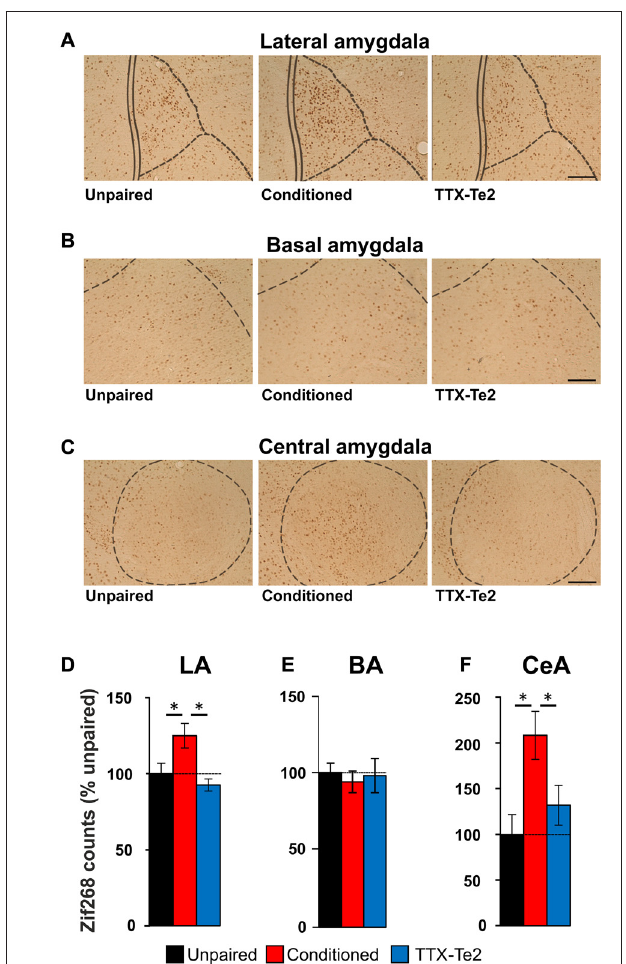
FIGURE 5 | The activity of individual lateral (LA), basal (BA) and central (CeA) amygdala nuclei after fearful memory recall. Photomicrography of zif268 staining in the LA (A) , BA (B) and CeA (C) nuclei of the amygdala in unpaired ( n = 12), conditioned ( n = 14) and TTX-injected conditioned ( n = 12) rats. Scale bars, 150 µ m. (D) LA activity was enhanced after long-term memory recall mainly in conditioned animals (Newman-Keuls test, P < 0.05) but not in those that received TTX after training (Newman-Keuls test, P > 0.05). (E) BA activity was similar among the three groups (One-way ANOVA). (F) zif268 staining in the CeA was enhanced by fearful memory retrieval only in conditioned rats (Newman-Keuls test, P < 0.05). All data are mean ± SEM. ∗ P <